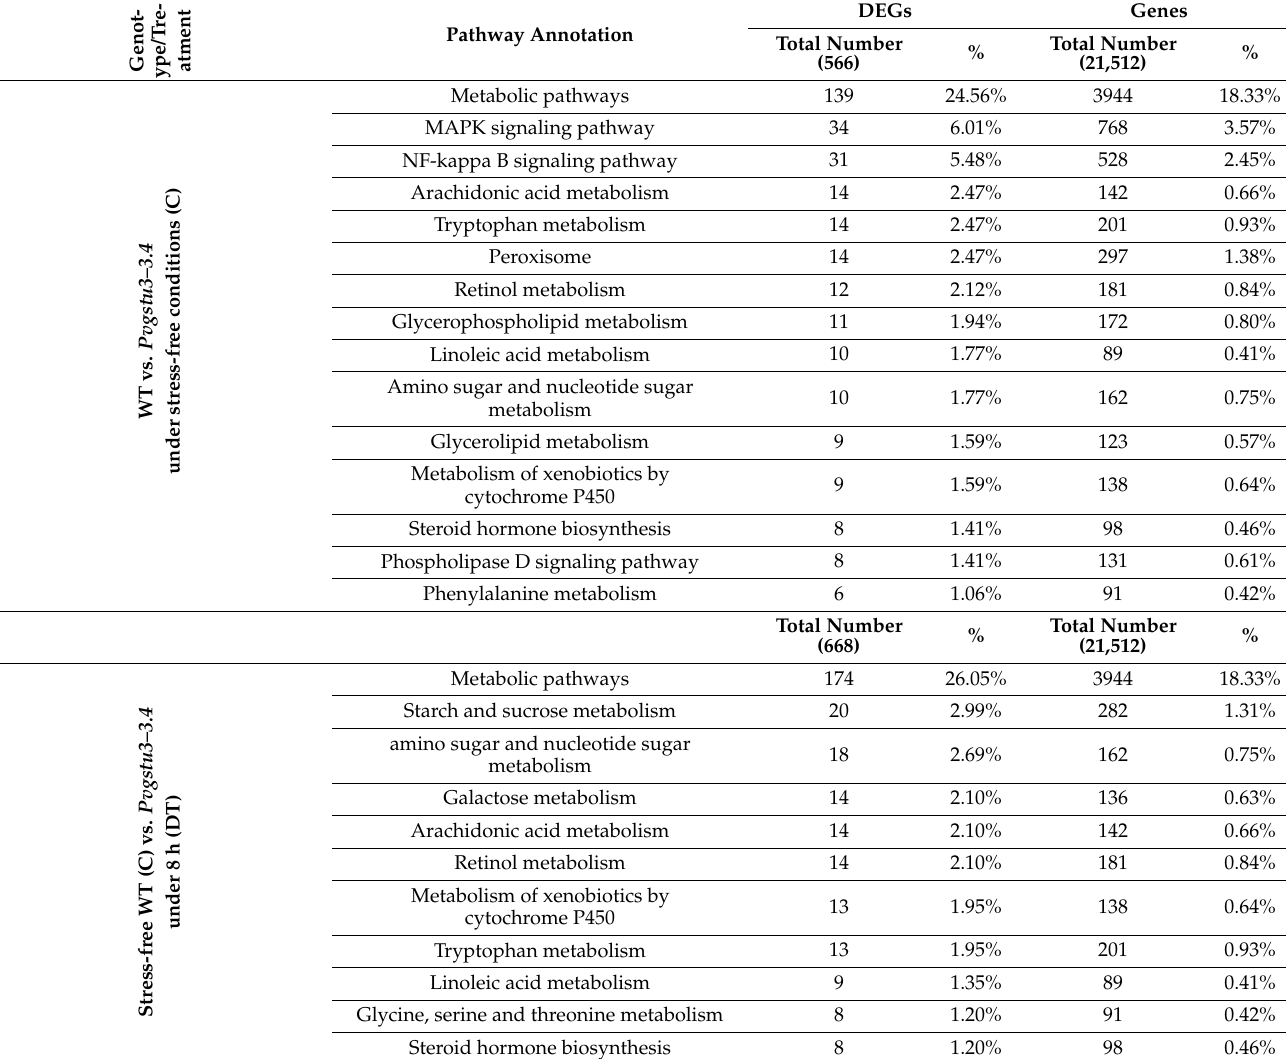
(Table 3). At 48 h under DT, the represented pathways aside from metabolic pathways (24.87%) included the carbon metabolism (3.46%), biosynthesis of amino acids (2.52%), starch and sucrose metabolism (2.46%), tryptophan metabolism (1.76%), arachidonic acid metabolism (1.70%), amino sugar and nucleotide sugar metabolism, retinol metabolism at 1.64%, whereas metabolism of xenobiotics by cytochrome P450, glycolysis/gluconeogenesis and glyoxylate and dicarboxylate metabolism at 1.51% (Table 3). Interestingly, when com- paring Pvgstu3–3.4 under DT at 48 h in reference to control conditions, DEGs of carbon metabolism (3.43%), AMPK signaling pathway, biosynthesis of amino acids and ABC transporters at 2.17%, pyruvate metabolism (1.79%), starch and sucrose metabolism (1.17%) and citrate cycle (TCA cycle) (1.39%) were involved in response to combined drought and heat stresses (Table 3). Table 3. Annotation and DEGs (total number and percentages) of pathways (results were determined using KEGG) showing a representative list of the significantly enriched biological process of a) WT vs. Pvgstu3–3.4 in stress-free control (C) conditions (0 h) (groups 1 vs. 2, respectively); b) stress-free Pvgstu3–3.4 (C) vs. Pvgstu3–3.4 at 48 h under DT (groups 2 vs. 4, respectively); c) stress-free WT (C) vs. Pvgstu3–3.4 at 8 h under DT (groups 1 vs. 3, respectively).; d) stress-free WT (C) vs. Pvgstu3–3.4 at 48 h under DT (groups 1 vs. 4, respectively). DT indicates combined drought and heat